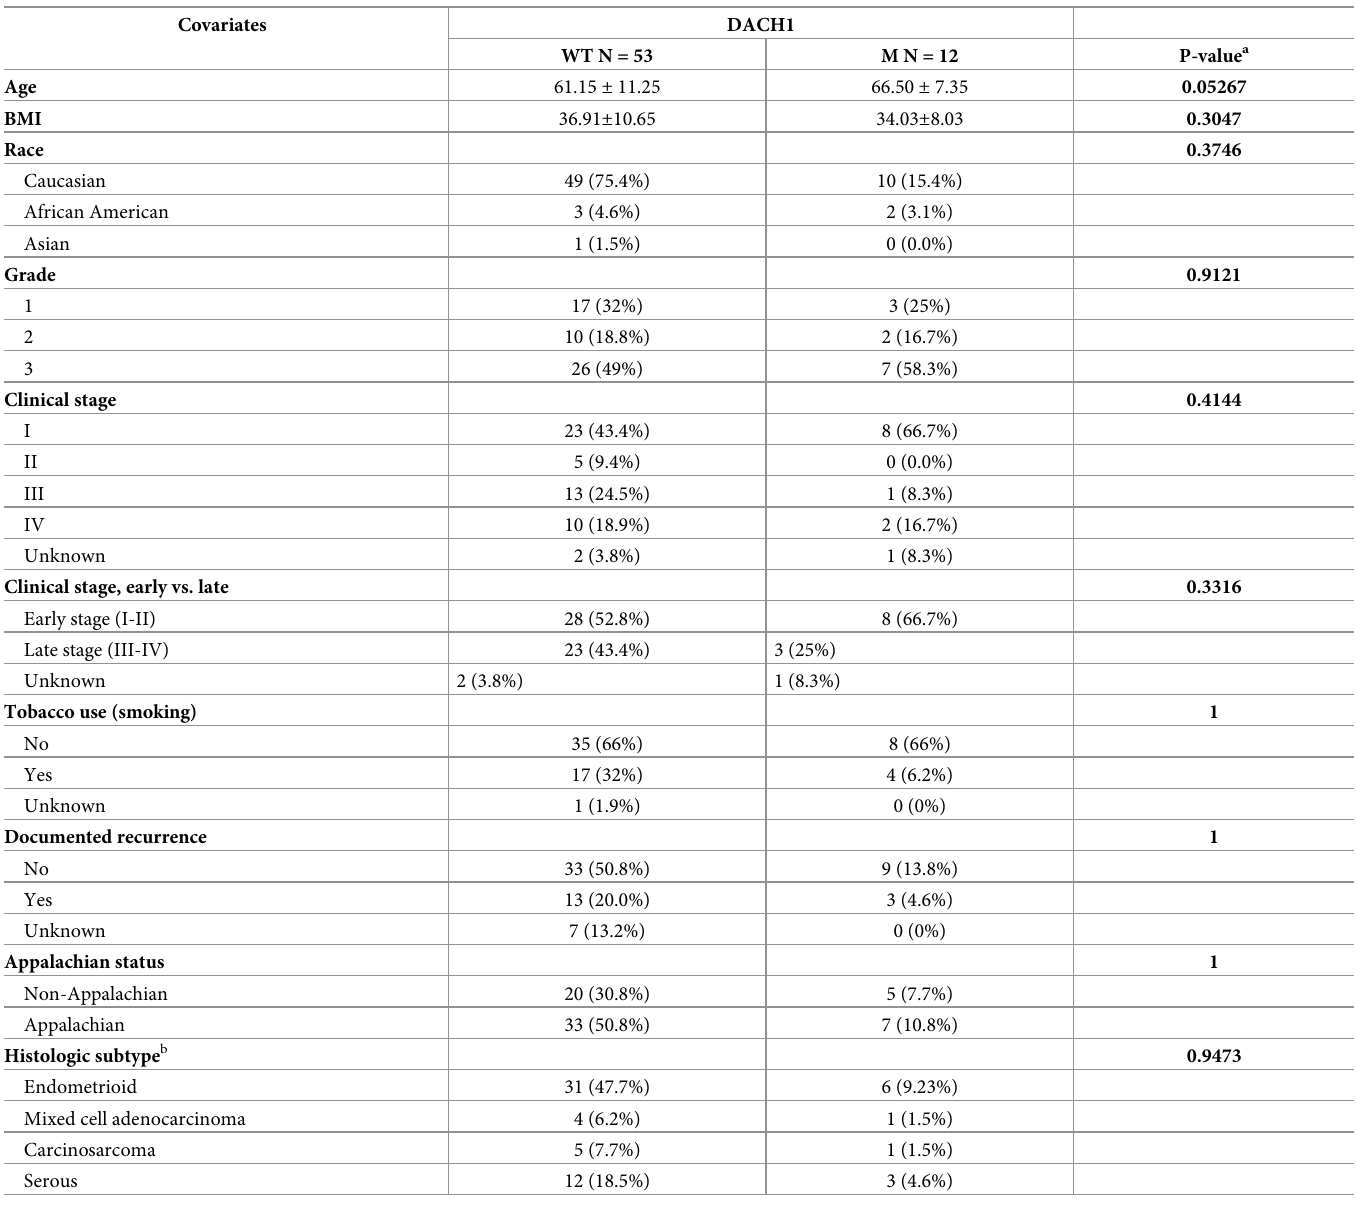
Table 3. Covariate analysis of DACH1 mutated patients compared to